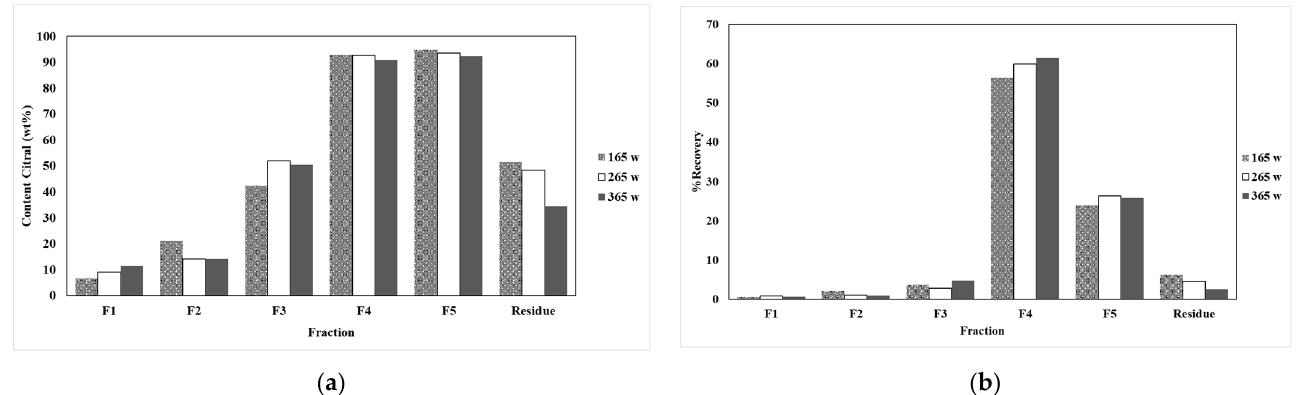
Figure 3. ( a ) Effect of the rate of distillation on the content of citral in the fractions; ( b ) Effect of the rate of distillation on the recovery of citral in the fractions.